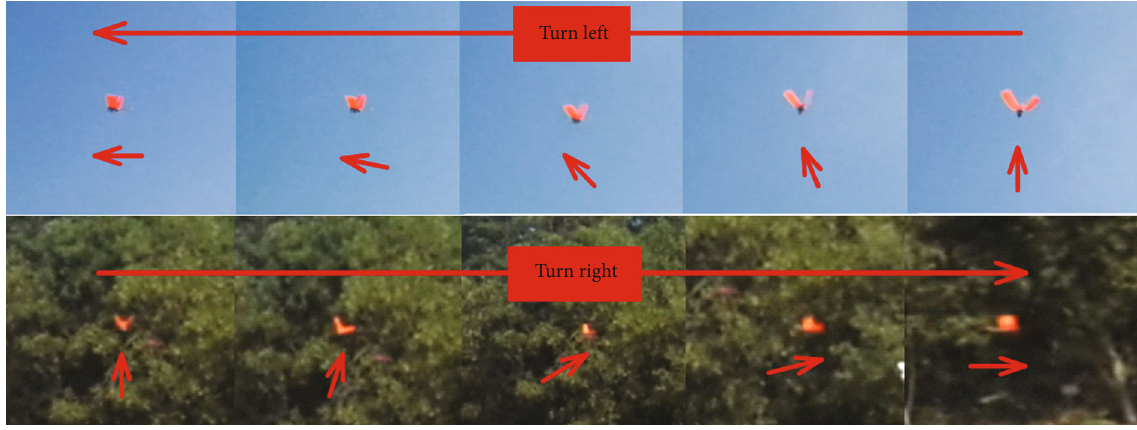
Figure 10: Test of turn fl